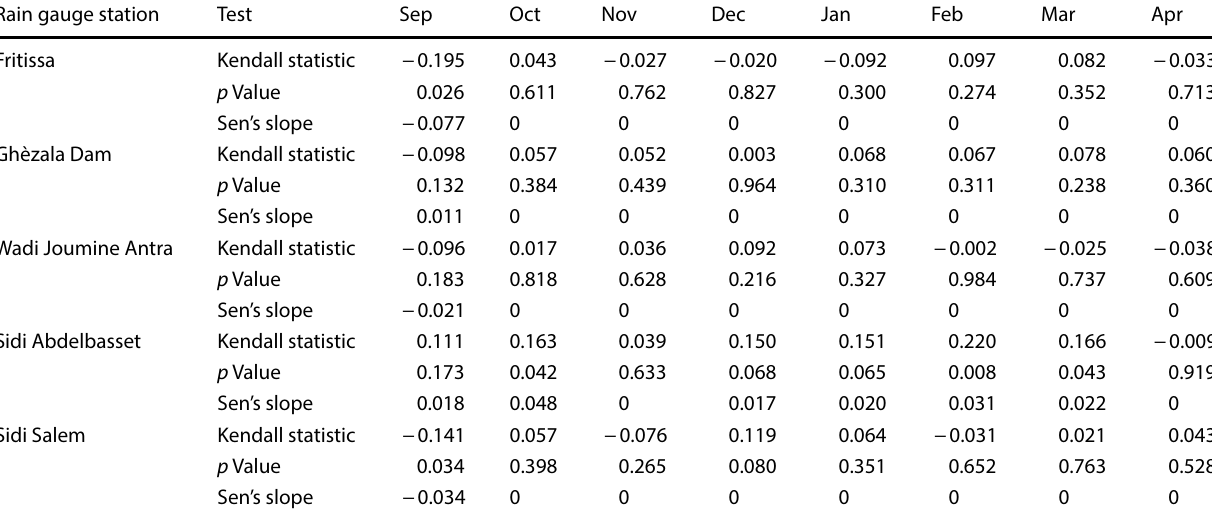
Table 10 Trends in the monthly dry spell length. Signification level (%): 5, (Sen’s slope): 95% Rain gauge station